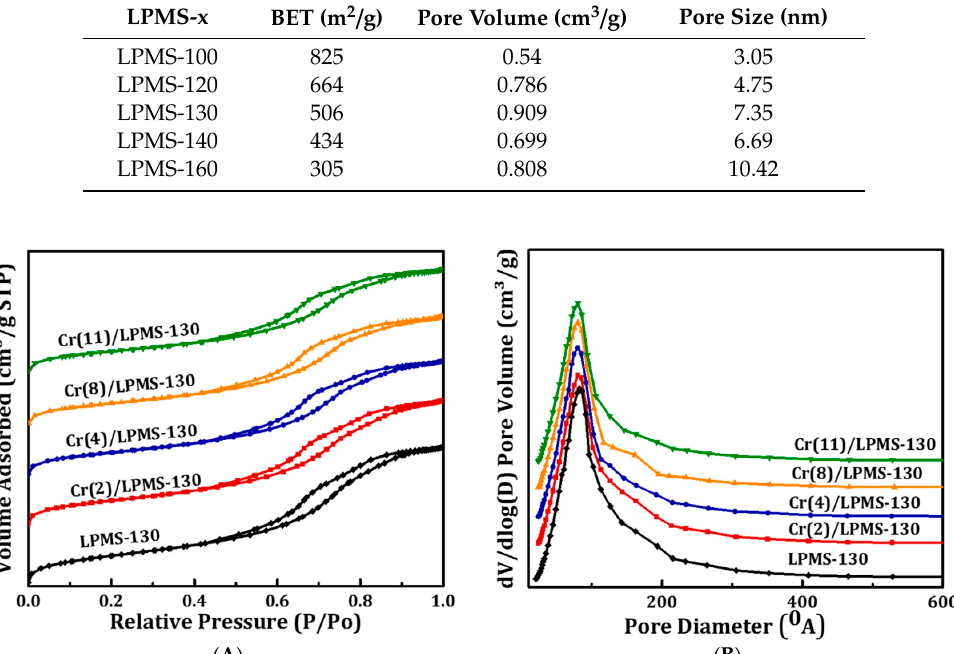
Figure 2. ( A ) N 2 sorption isotherms and ( B ) pore size distribution of Cr(y) / LPMS-130 prepared by varying the Cr loading wt